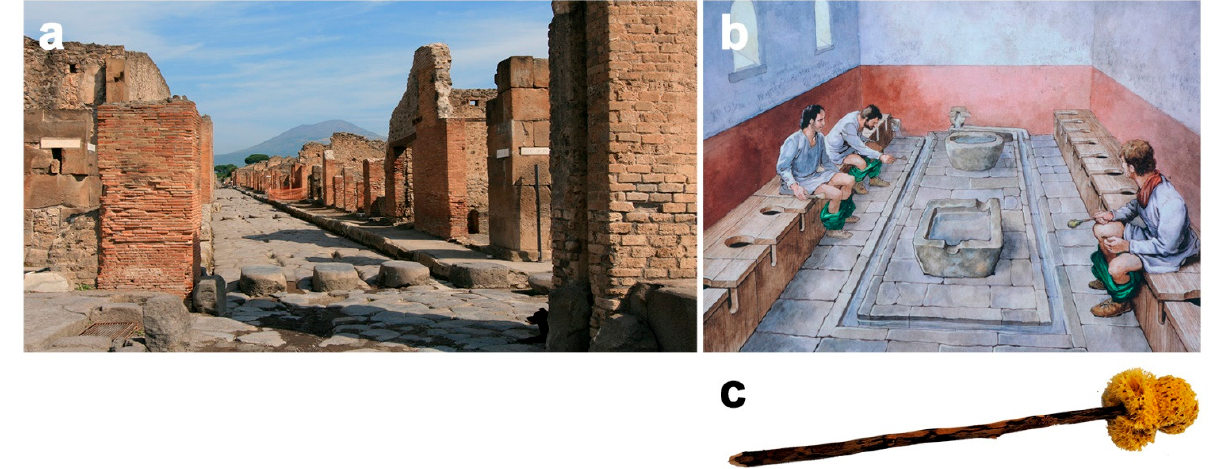
Figure 7. ( a ) Stepping-stones in Via Stabiana ( Pompeii ), whose function was to keep Romans’ feet dry and out of the rainwater, slop and animal waste that would have filled the streets [Author: Jensens. Distributed under a CC0 license. Available online: https://cutt.ly/aRCZ8V8. Accessed: 30 October 2021]. ( b ) Reconstruction drawing showing the communal latrines in use [Author: Carole Raddato. Distributed under a CC BY-SA 2.0 license. Available online: https://cutt.ly/dRCZ471. Accessed: 30